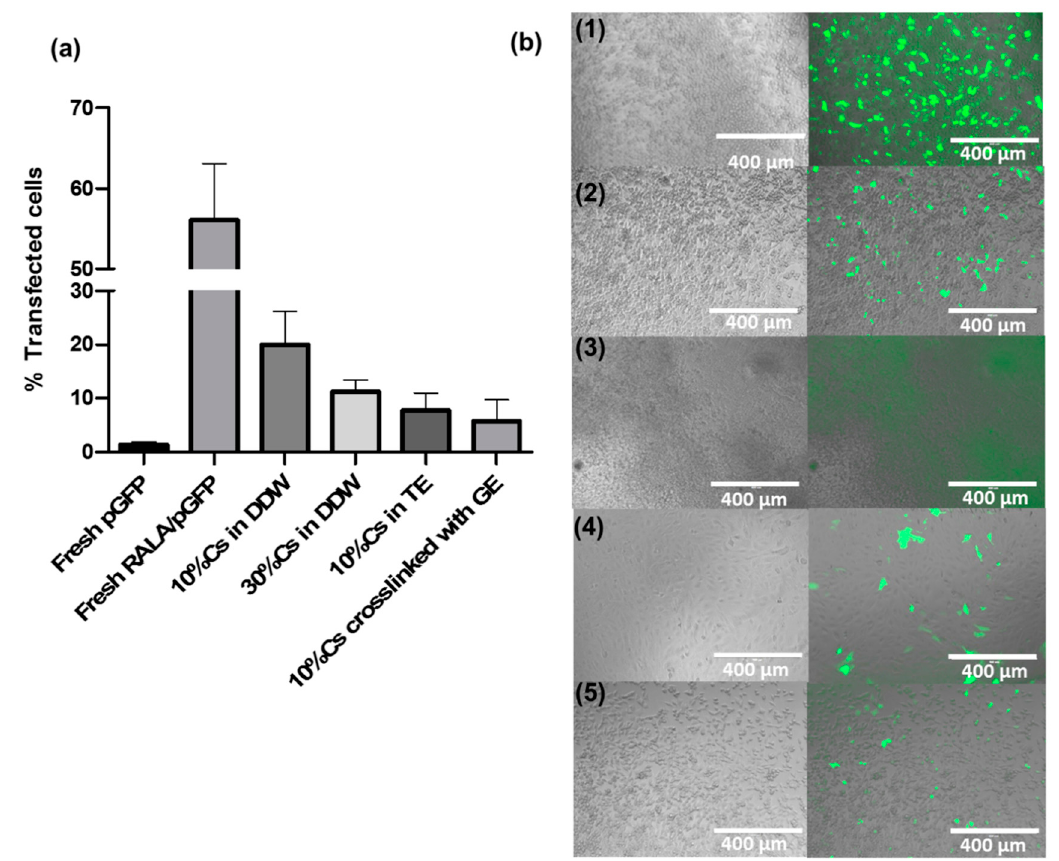
Figure 8. Assessment of DNA transfection efficiency of NCTC-929 cells after incubation with RALA/GFP NPs released from Cs-g-PNIPAAm hydrogels at 24 h time point. ( a ) Flow cytometry analysis showed varied transfection efficiency of RALA/GFP NPs released from the hydrogel formulations. ( b ) Cells transfection efficiency was visualized with the presence of green fluorescent protein expressed by the NCTC-929 cells for (1) fresh NPs, (2) NPs released from 10% Cs-g-PNIPAAm in DDW, (3) NPs released from 30% Cs-g-PNIPAAm in DDW, (4) NPs released from 10% Cs-g-PNIPAAm in Tris-EDTA (TE) buffer, and (5) NPs released from 10% Cs-g-PNIPAAm in DDW crosslinked with 1% GE.